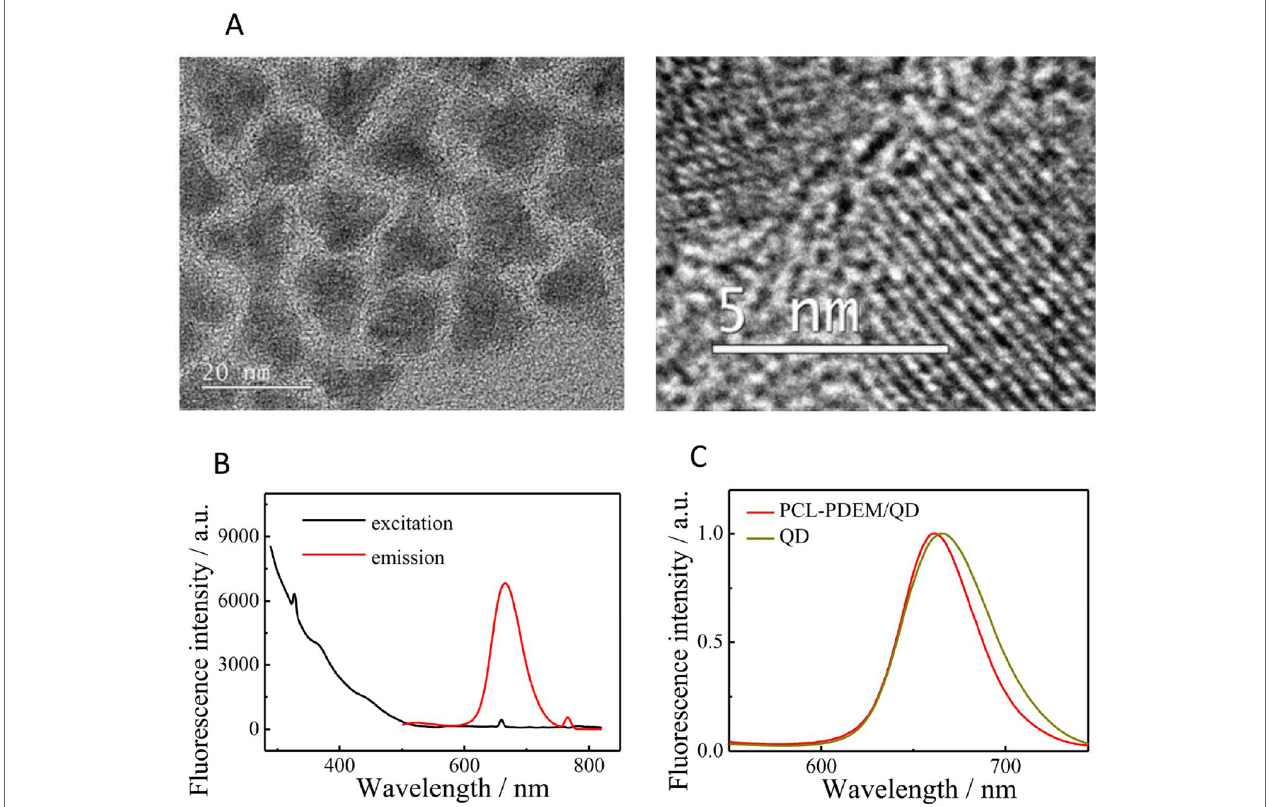
FIGURE 3 | The characterization of CdSSe/ZnS QDs. (A) TEM of QDs, (B) the fluorescence spectra of QDs (0.02 mg ml −1 in toluene, ex: 380 nm, em: 660 nm), (C) the fluorescence spectra of PCL-PDEM/QD micelles.